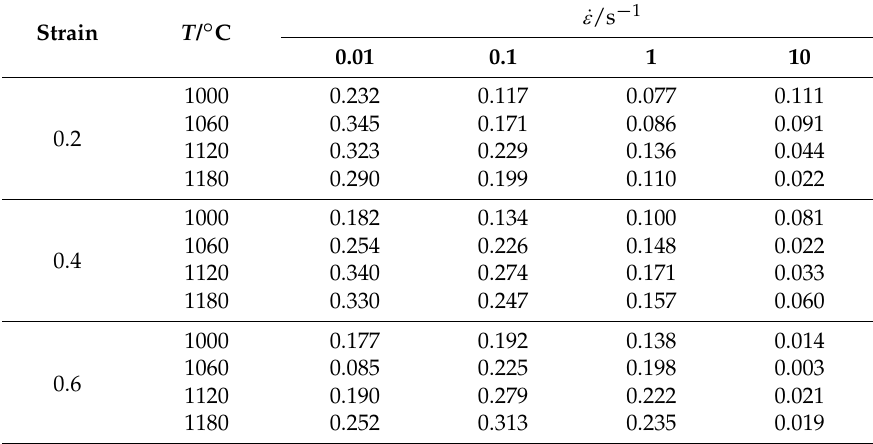
Table 4. The relative error ( ARRE ) between theoretical and corrected experimental. Table 6. The value of m of each computing node at different deformation temperatures.